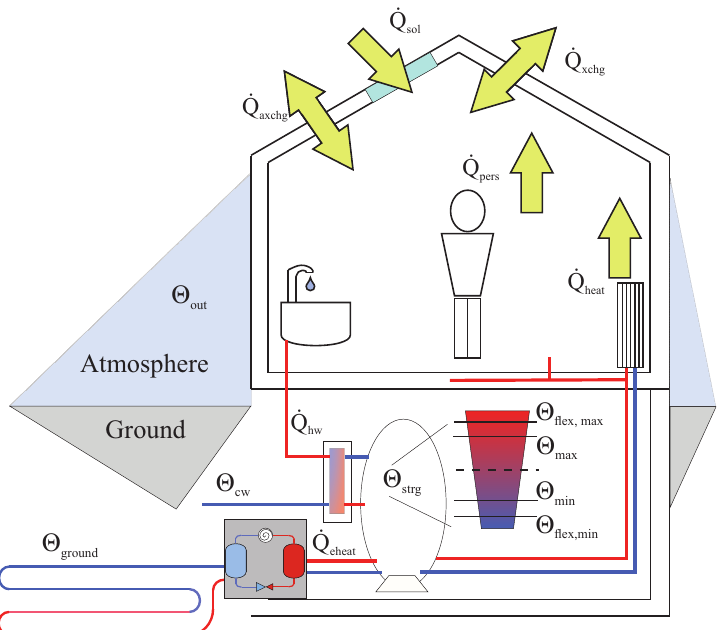
Figure 6. Thermal dynamics within the applied heating model with outer θ out , ground θ ground , and cold water temperature θ cw with normal and flexible setpoints for storage tank temperature θ strg,flex,min/max